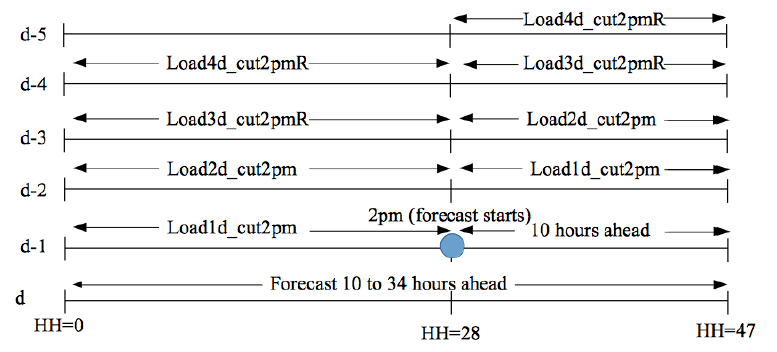
Figure A7. Demand prediction horizon: practice in Thailand.